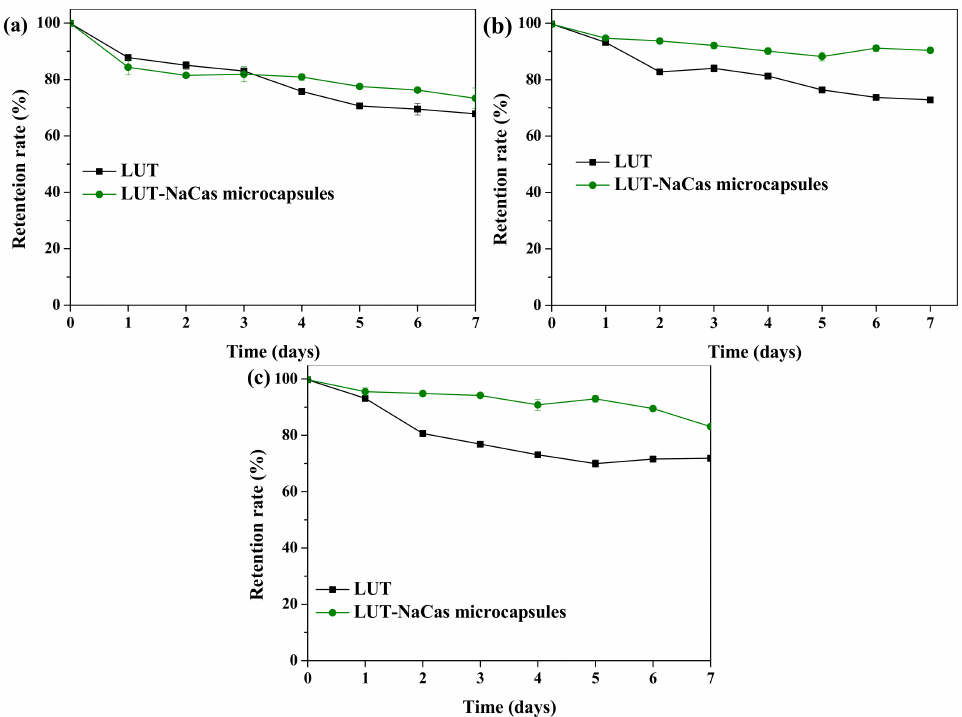
Figure 3. Effect of storage pH values ( a ) pH 2; ( b ) pH 5; ( c ) pH 7 on the retention rate of lutein (LUT) in its natural form and lutein-enriched microcapsules stabilized by sodium caseinate after 7 days of storage. Data points represent means (n = 3) ± standard deviations. Some error bars lie within the data